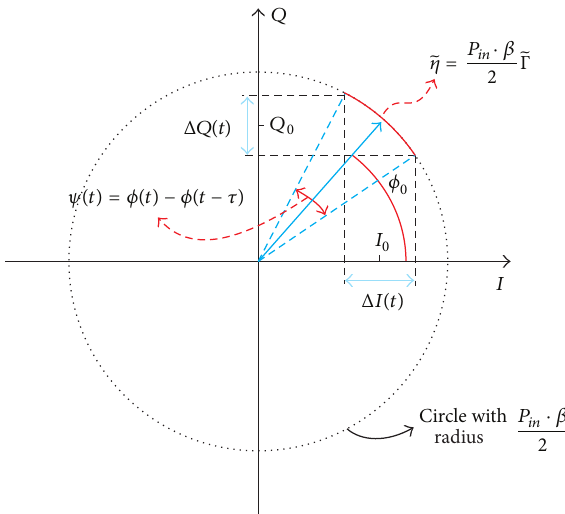
Figure 5: Complex plane representation of the complex variable ̃𝜂(𝑡)